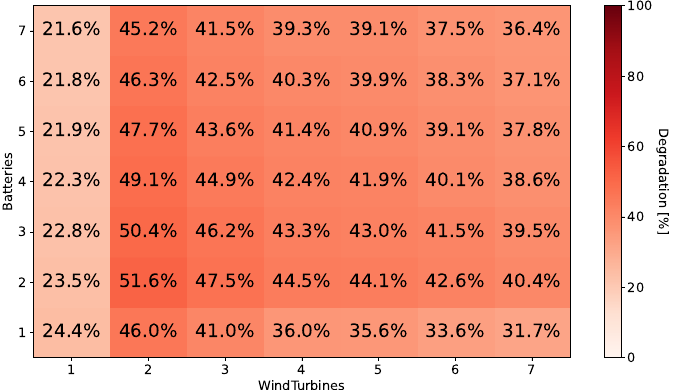
Figure 25. Degradation of the batteries over 20 years of usage with strategy 2.